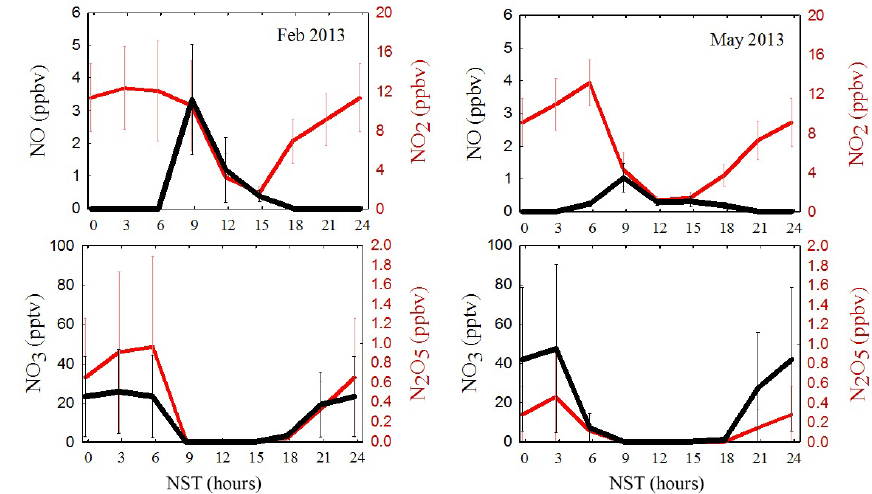
Figure 7. Model-simulated average diurnal variations in NO, NO 2 , NO 3 and N 2 O 5 during February and May 2013. Table 1. Monthly variations in O 3 and CO over Bode, Nepal, during January–June 2013. Month Ozone (ppbv) Max/min (ppbv) Daytime average ozone CO (ppbv) Max/min (ppbv) ppbv (1100–1700h)